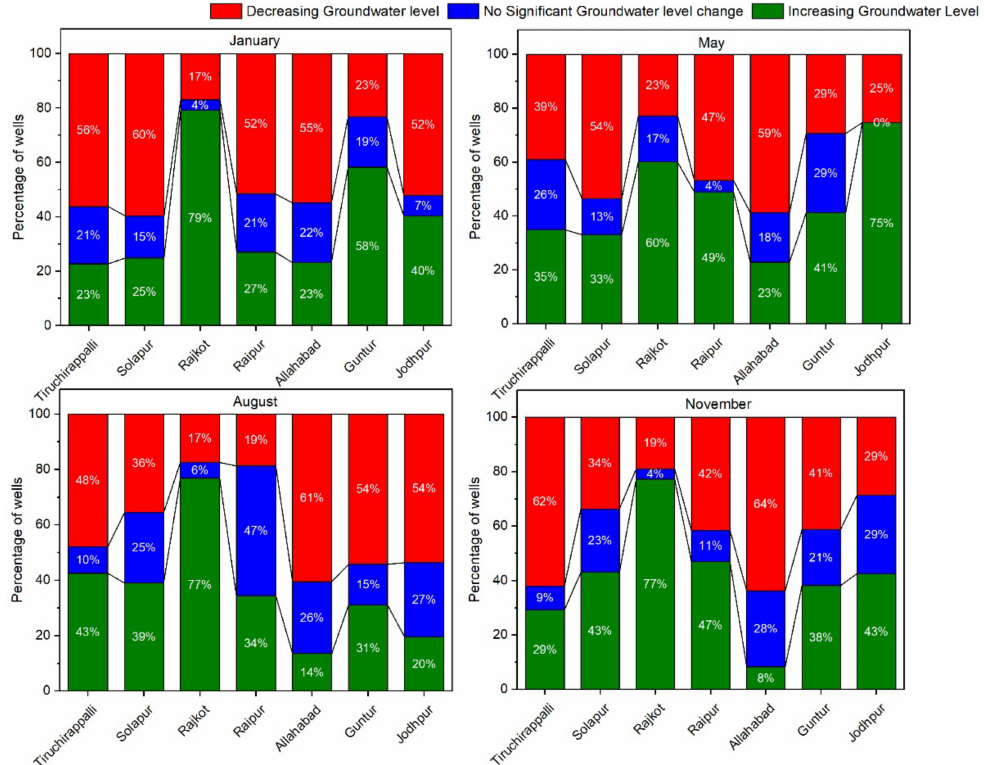
Figure 4. City-wise seasonal split-up of the wells with groundwater level trends. In majority of the selected cities, the decreasing GWL trend was found to be higher in majority of the wells throughout the season. In about ~9–47% of the wells, GWL changes occurred only between ± 2 cm / year throughout the seasons. At the city level, Rajkot has the highest percentage of wells with increasing GWL and Allahabad has the highest percentage of wells with decreasing GWL with a significant trend ( > 2 cm /